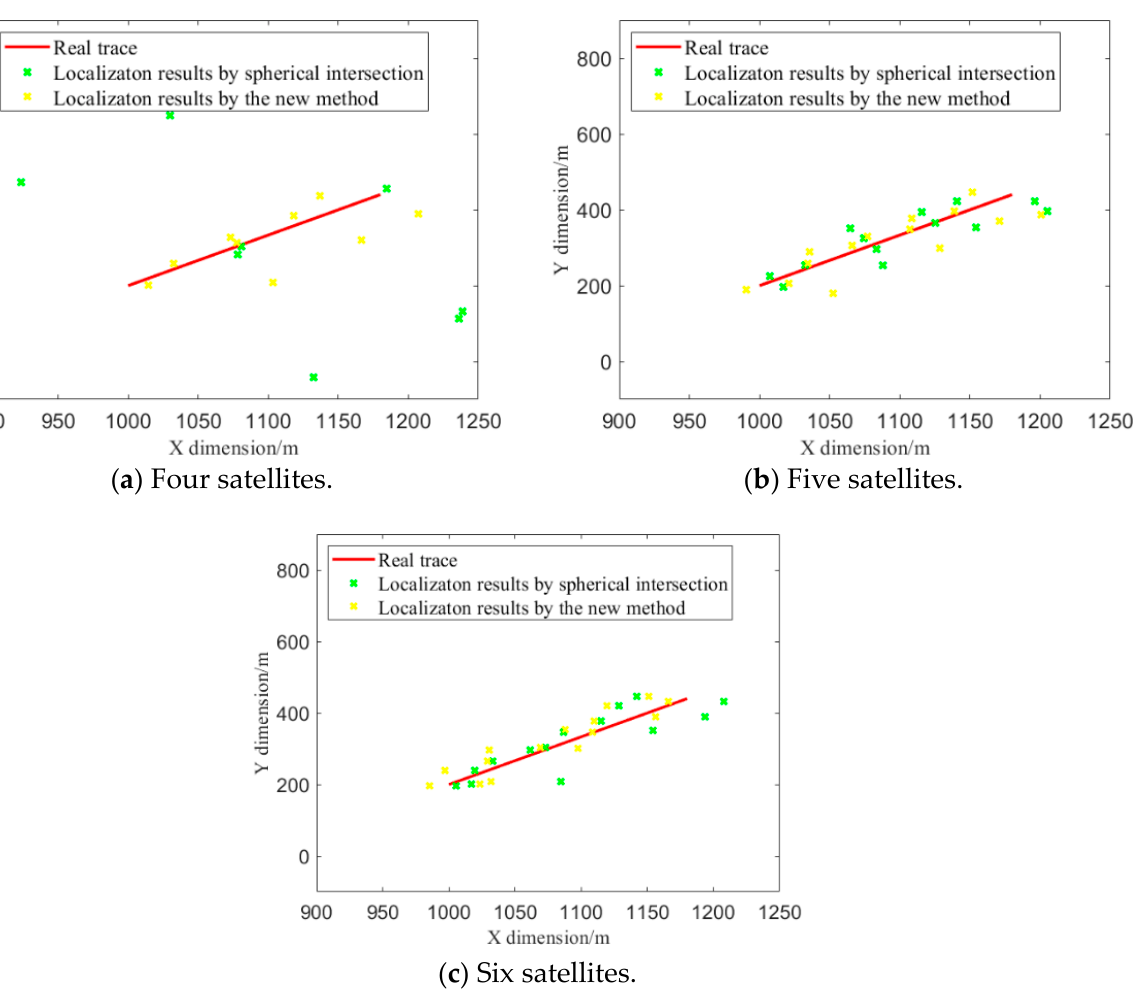
Figure 7. Localization results.